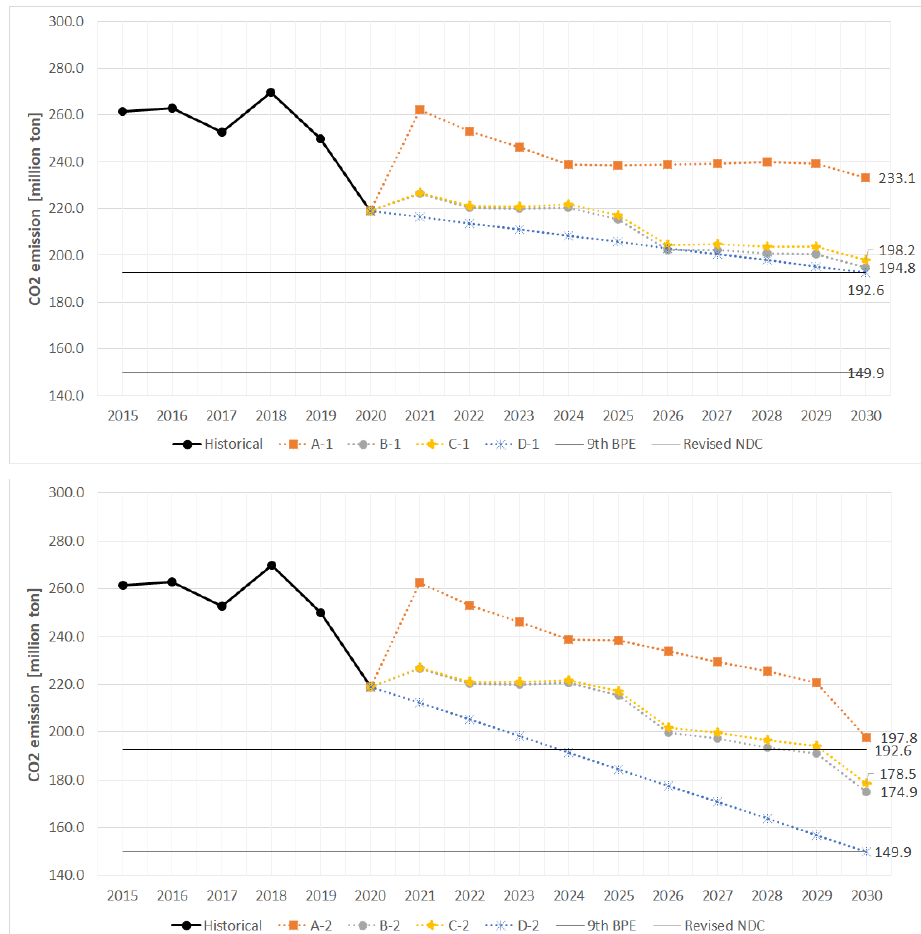
Figure 6. Projected annual CO 2 emission trajectories of all scenarios.